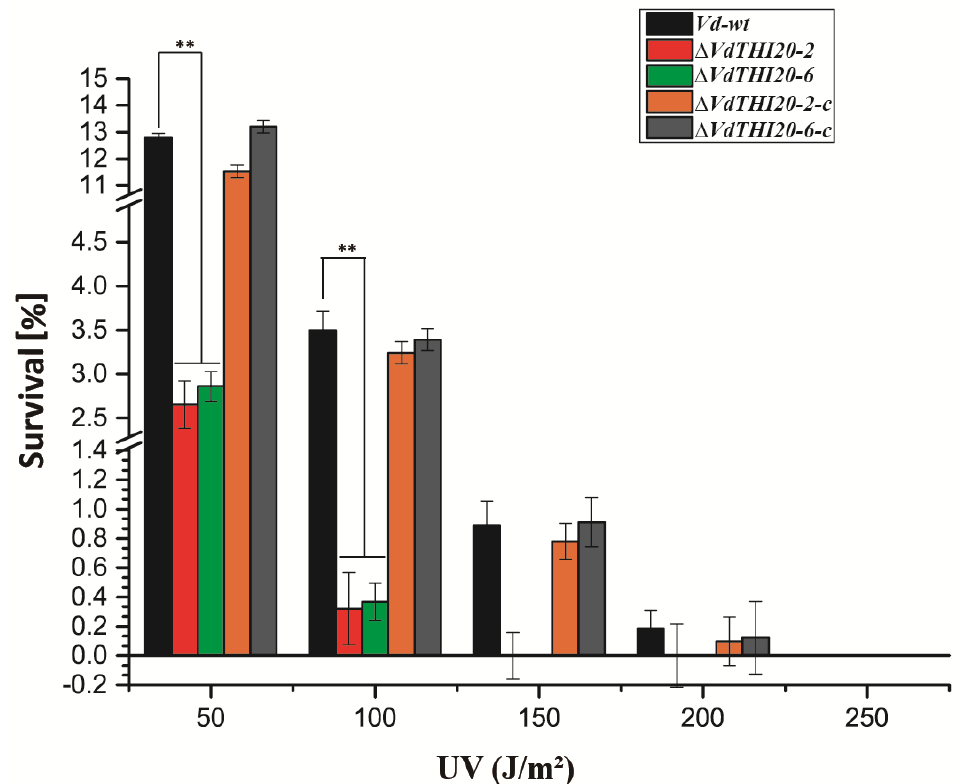
Figure 6. Effect of UV radiation on the growth of the Vd-wt strain, ΔVdTHI20 mutant strains ( ΔVdTHI20-2 and ΔVdTHI20-6 ), and complemented strains ( ΔVdTHI20-2-c and ΔVdTHI20-6-c ). The ΔVdTHI20 mutant strains were hypersensitive to UV radiation compared with the Vd-wt and complemented strains. The percentages of surviving colonies were computed after UV exposure at 50, 100, 150, and 200 J/m 2 . The reduction of survival of the ΔVdTHI20 mutant strain colonies after UV-treatment at 50 and 100 J/m 2 in comparison to that of the Vd-wt strain is significant. The reduction is restored in the complemented ∆VdTHI20 mutant strains. Statistical analyses of survival indicated no significant difference between the complemented strains and the Vd-wt strain. Values represent the mean ± standard deviation from three independent replicates. Asterisks (**) indicate significant differences by Student’s t test at P < 0.01.